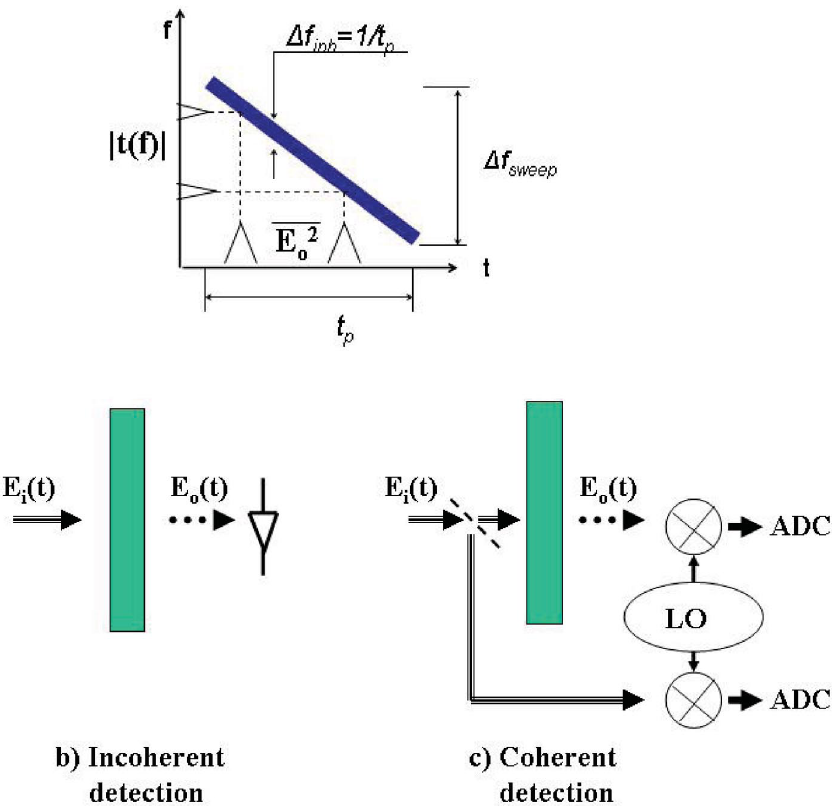
(cid:5) t (cid:6) is i